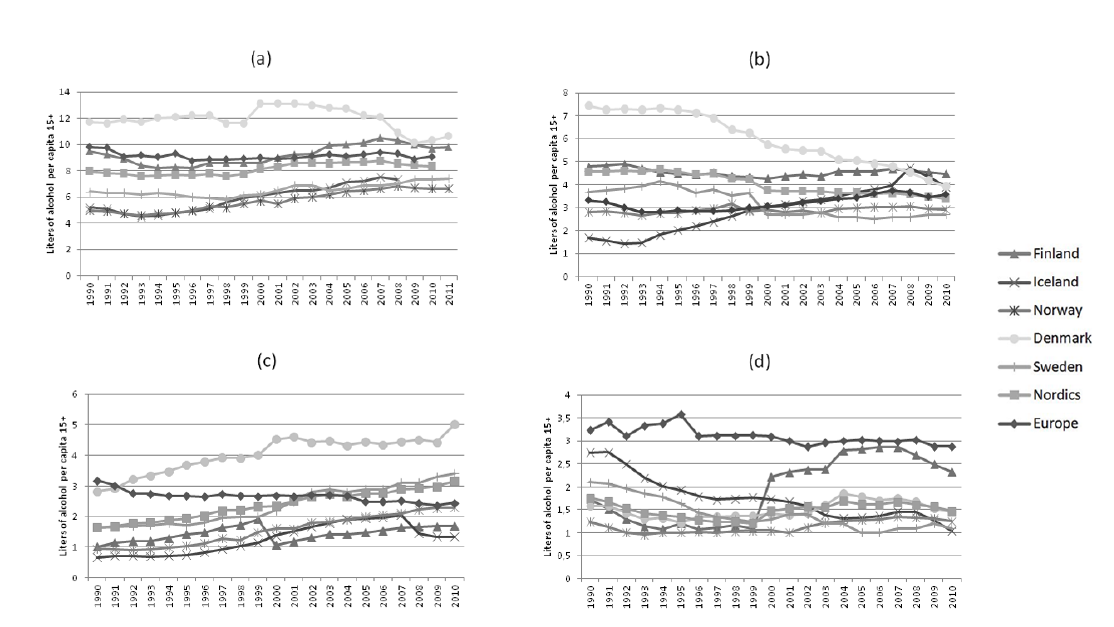
Consumption of alcohol per capita of individuals aged fifteen or older,